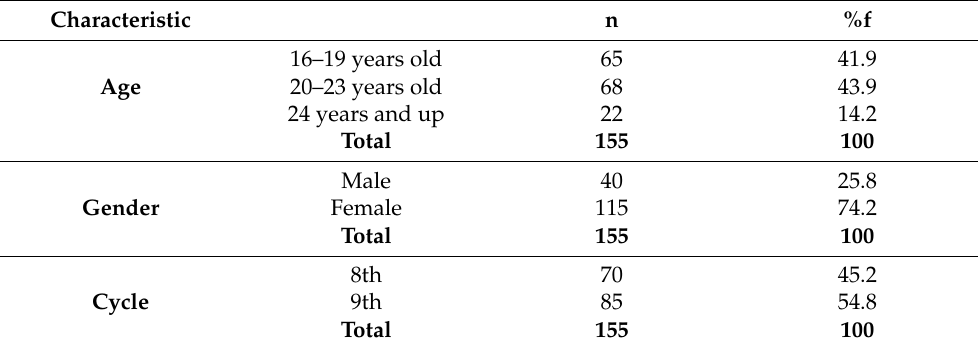
Table 4. Sociodemographic information of the students at the industrial engineering school of a public university in Lima.